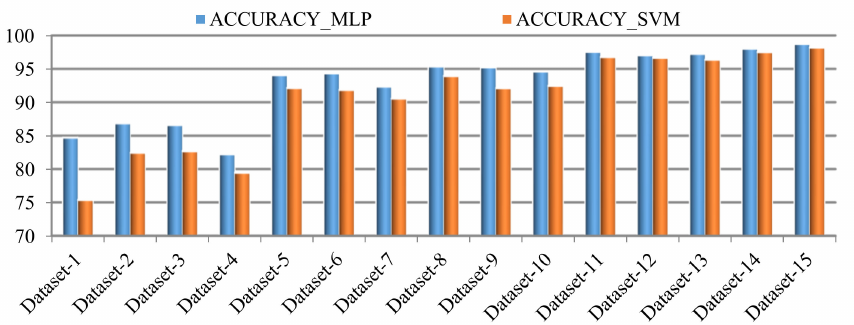
Figure 7. Comparative analysis of recognition accuracy achieved by MLP and SVM classifiers for proposed feature‑extraction